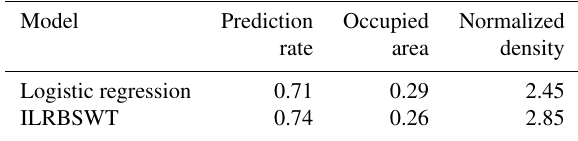
Table 1. Parameters extracted from the intersection points in Fig. 10a and